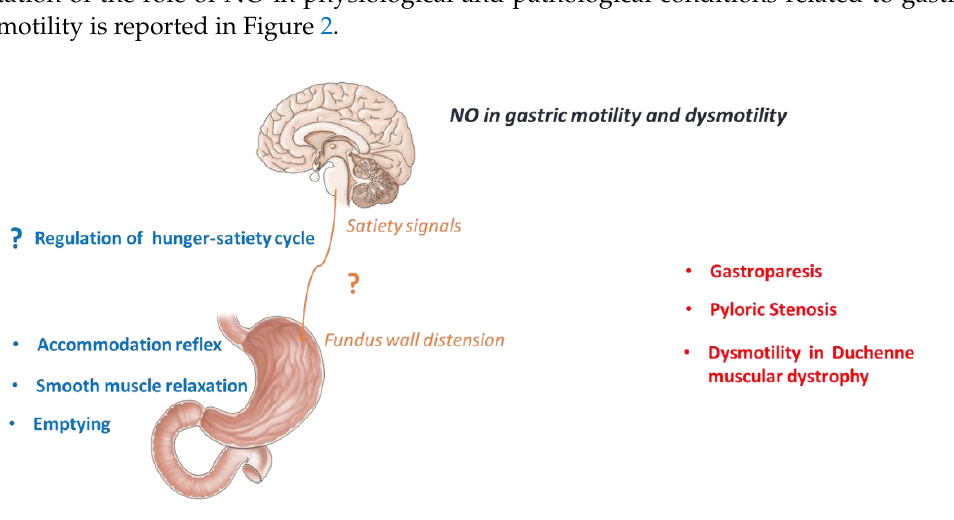
Figure 2. Physiological role of NO in the control of gastric motility (in blue) and the main motor dysfunctions of the stomach associated to a NO system alteration (in red) reported in humans or animals.